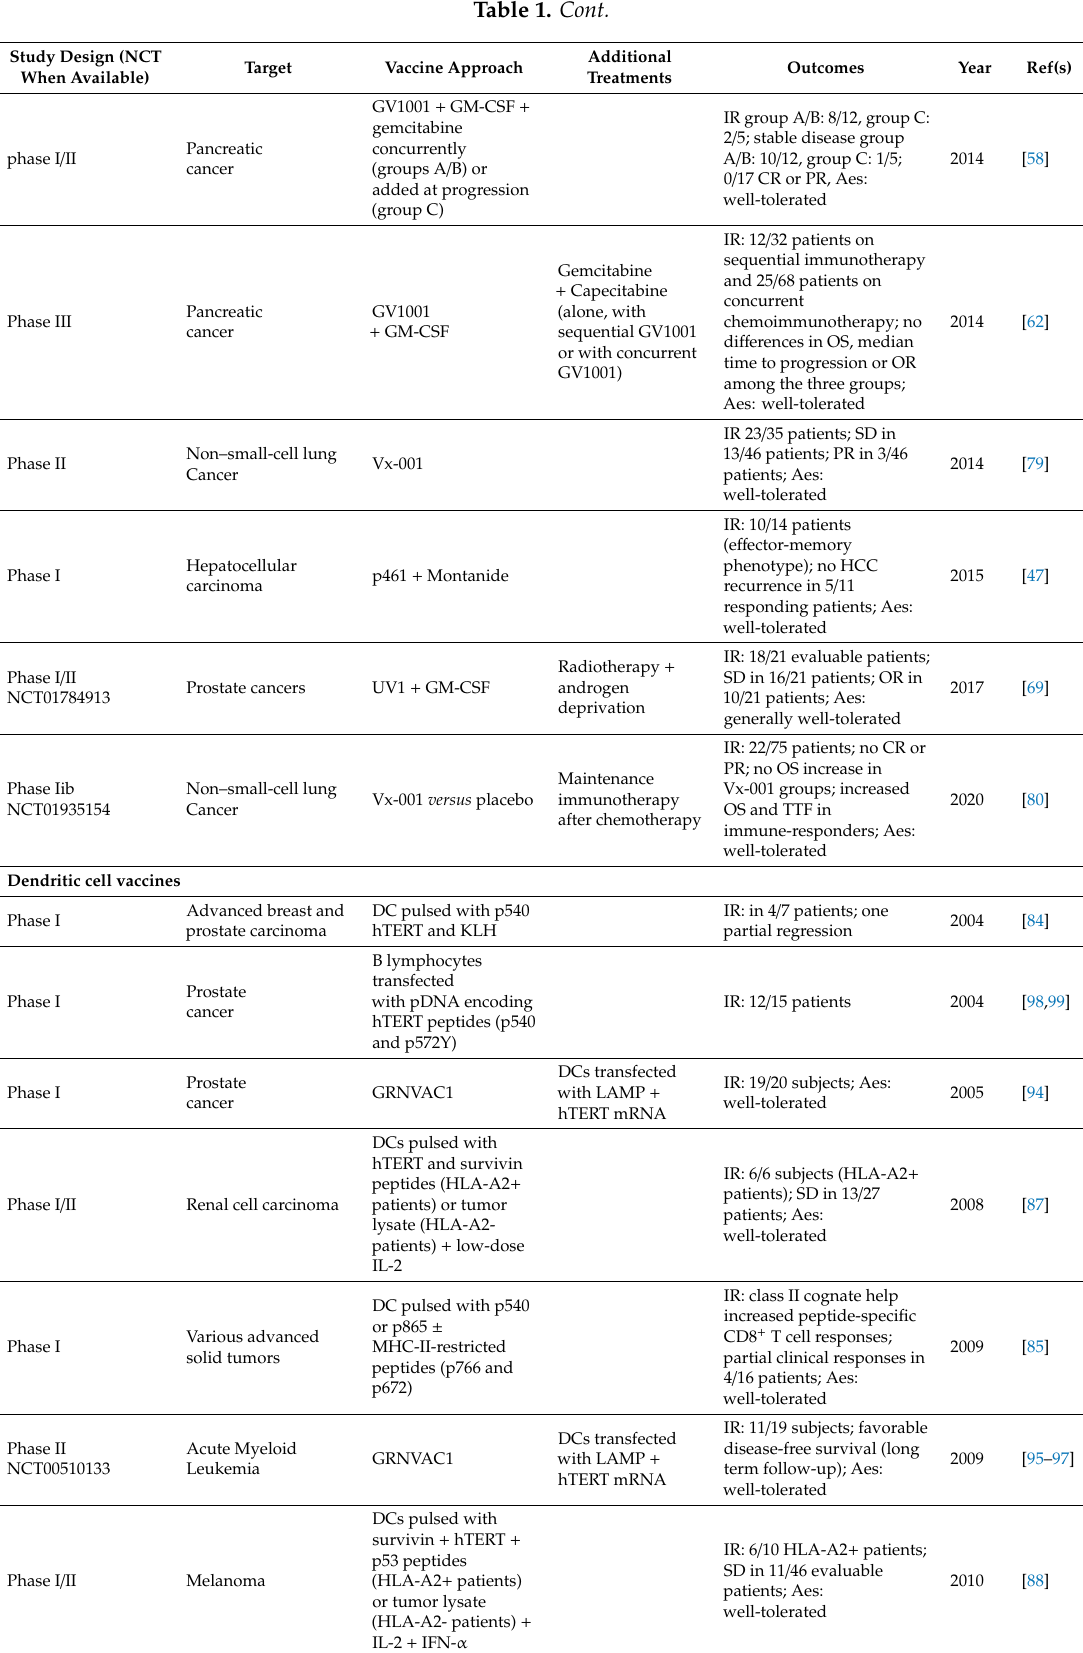
Study Design (NCT When